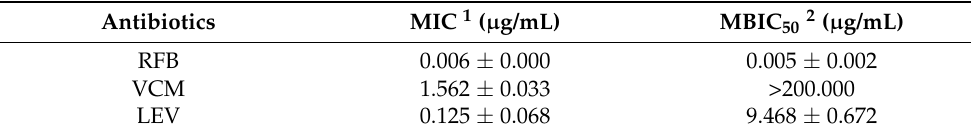
Table 1. Planktonic and biofilm MSSA susceptibility to the three selected